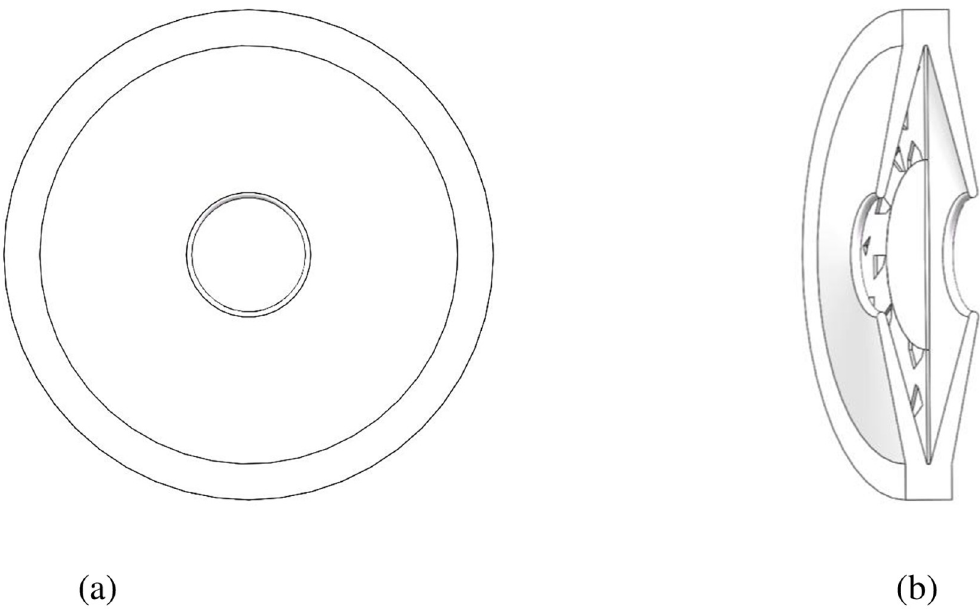
) is given by the tot